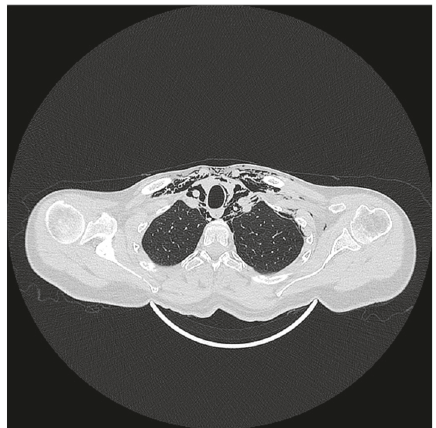
Figure 1: Computed tomographic axial view of the emphysema in the maxillary region.